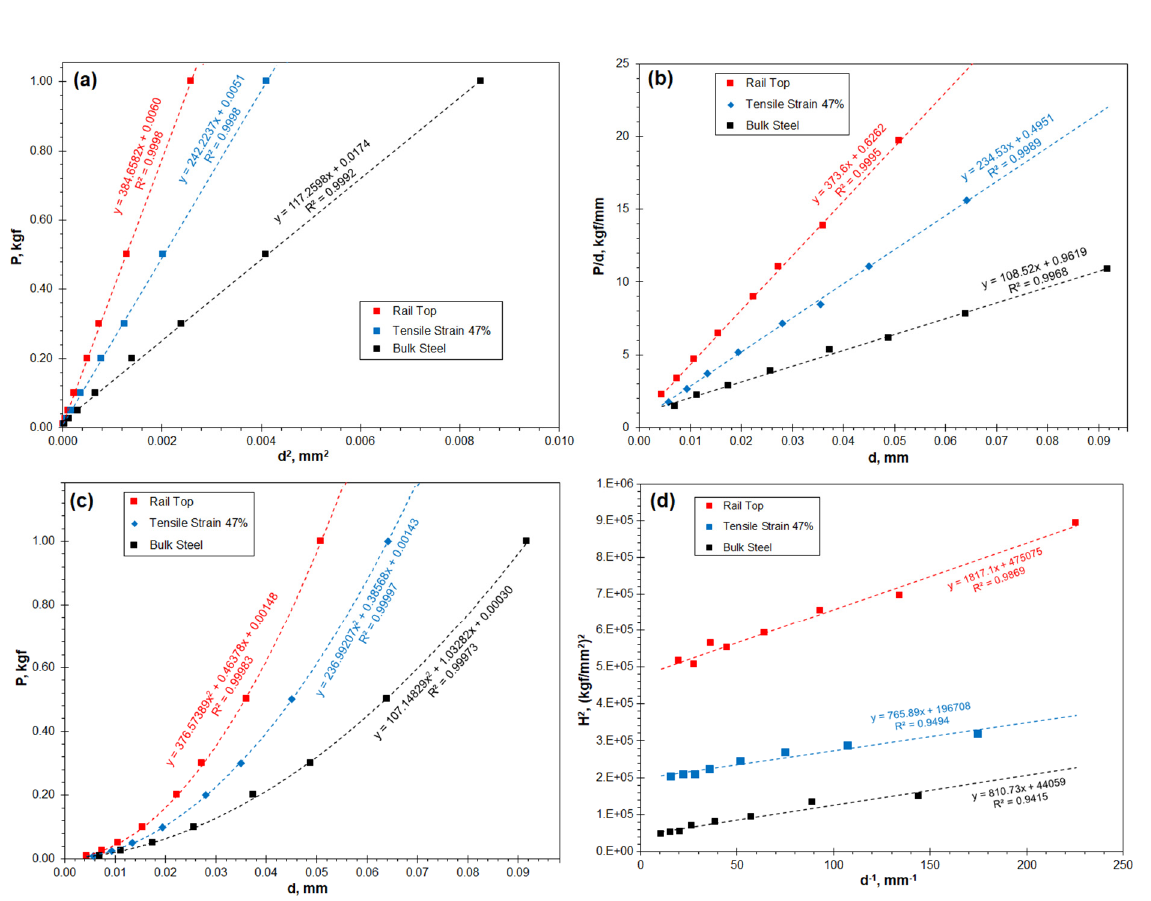
Figure 6. Linear regression plots to calculate the real hardness of the three Hadfield steel samples using the theoretical models: ( a ) using the Hays–Kendall model; ( b ) using the Li–Bradt model; ( c ) using the Bull model; and ( d ) using the Nix-Gao model. Table 3. Determination of the real hardness ( H 0 , in kgf/mm 2 ) of the strained Hadfield steel using the theoretical models.